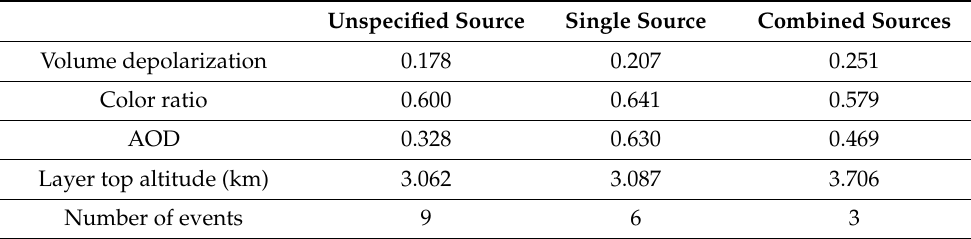
Table 4. Characteristics of dust layers observed within 440 km of Kuwait City analyzed from the CALIPSO